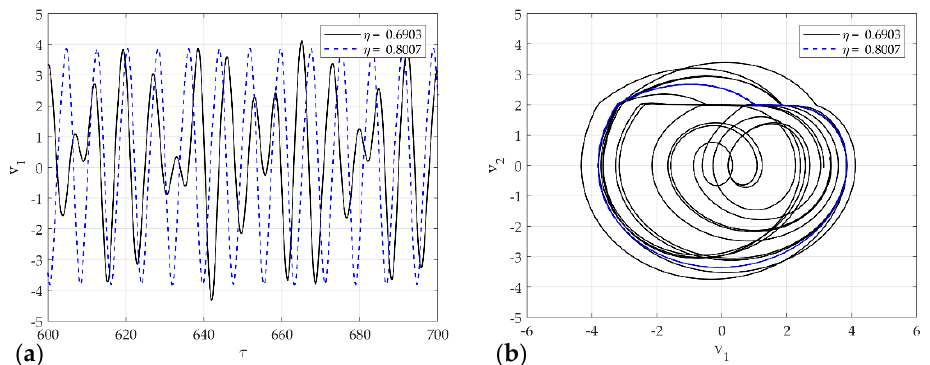
Figure 13. Dynamic solutions for single-mode squeak model for various η : ( a ) time analysis; ( b ) phase portrait corresponding to ( a ).